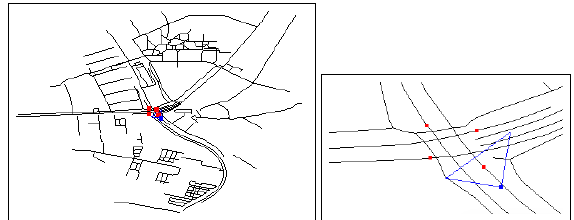
Figure 1: Left: the road links and traffic lights (red points) in the vicinity, 500 meters × 500 meters, of the platform (blue point). Right: the traffic light which is within the region of interest is selected from OpenStreetMap. The region of interest, which is the field of view of the camera up to 70 meters, is shown in blue